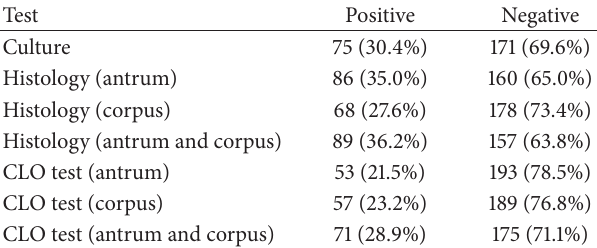
Table 2: Results of detection of H. pylori by each